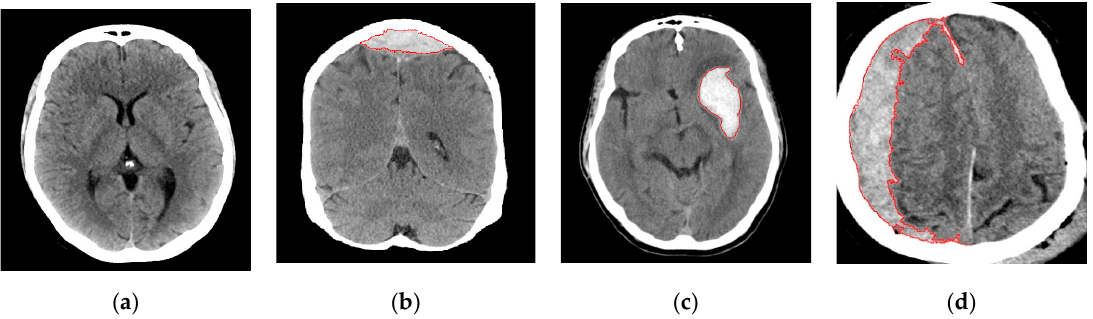
Figure 1. ( a ) Normal brain image is compared with the three types of hemorrhage: ( b ) epidural hemorrhage, ( c ) intraparenchymal hemorrhage, and ( d ) subdural hemorrhage.